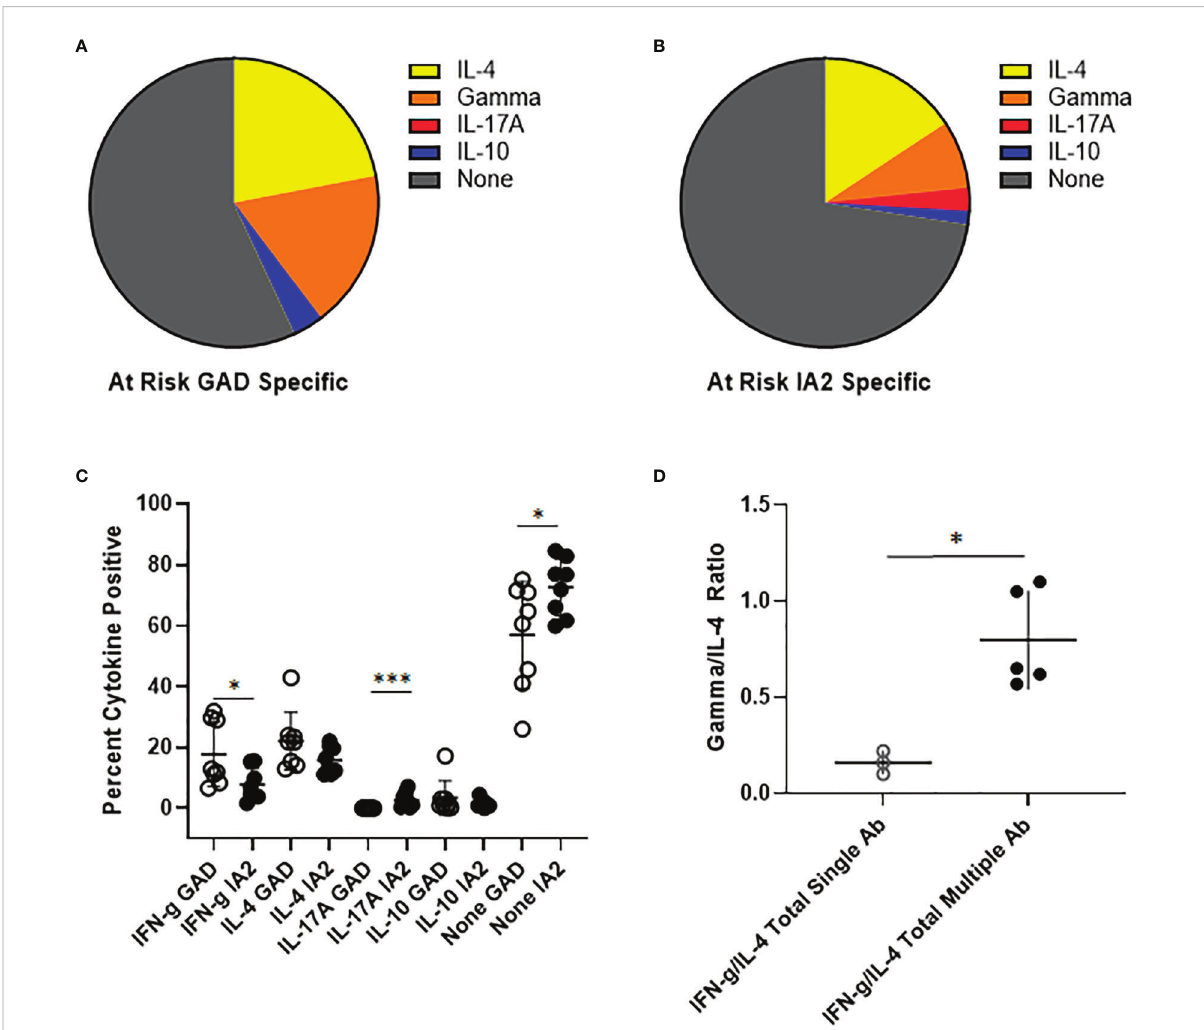
FIGURE 5 PTM speci fi c T cells have distinct cytokine pro fi les in at-risk subjects. PTM GAD and IA-2 epitope speci fi c T cells were characterized by intracellular cytokine staining after a single round of in vitro expansion. (A) The cytokine pro fi les of PTM GAD speci fi c T cells were examined for 8 antibody positive at-risk subjects. Taking the average across all subjects, IL-4 was the predominant cytokine (22%) followed by interferon- g (17.8%), IL-10 (3.4%), and IL-17A (0.03%); a notable proportion were cytokine negative (57%). No notable dual cytokine production was observed. (B) The cytokine pro fi les of PTM IA-2 speci fi c T cells were examined in the same 8 at-risk subjects. Taking the average across all subjects, IL-4 was predominant (15.7%) followed by interferon- g (7.6%), IL-17A (2.6%), and IL-10 (1.5%); a major proportion were cytokine negative (72.6%). Again, no notable dual cytokine production was observed. (C) Comparing PTM GAD (white circles) and IA-2 speci fi c T cells (black circles) in at- risk subjects, a signi fi cantly higher percentage of PTM GAD speci fi c T cells were interferon- g positive (p=0.049, Mann Whitney test) and a signi fi cantly lower percentage were IL-17A positive (p=0.0002, Mann Whitney test) or cytokine negative (p=0.049, Mann Whitney test). (D) Grouping subjects based on single (open circles) or multiple ( fi lled circles) autoantibodies revealed that the single autoantibody group had signi fi cantly lower ratios of interferon- g to IL-4 than the multiple autoantibody group (p=0.036, Mann Whitney test). Horizontal lines in each panel indicate the mean value for each group. Vertical lines indicate standard deviations. * indicates p-value below 0.05 but above 0.01 ** indicates p-value below 0.01 but above 0.001 *** indicates p-value below 0.001 but above